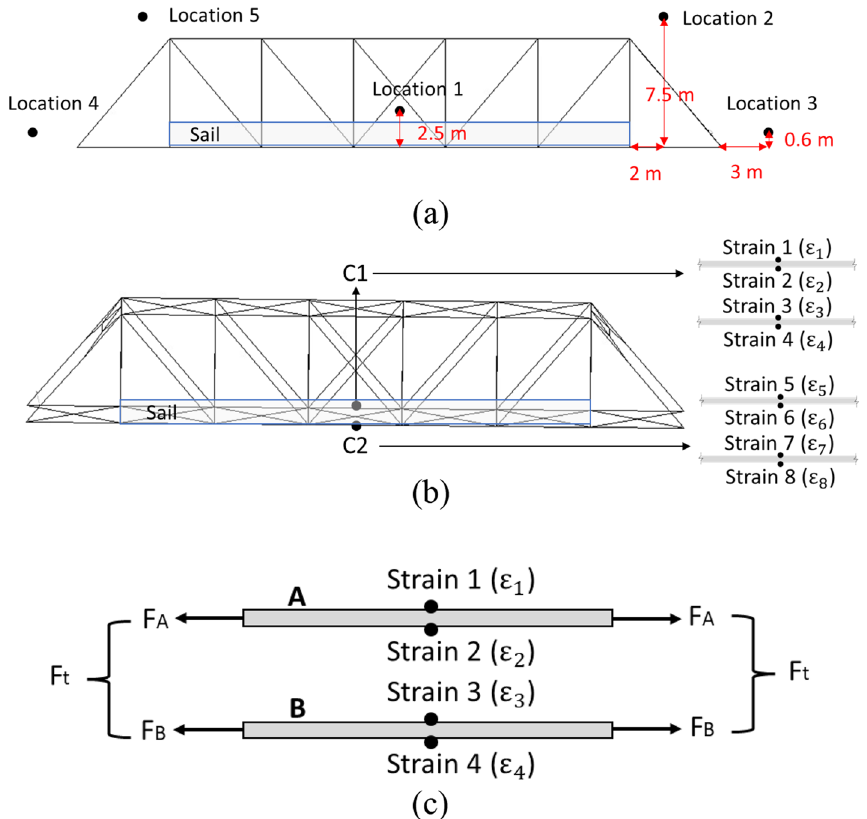
Fig. 2 Experimental setup: a locations for measuring wind speed; b monitored members; c calculation of wind-induced